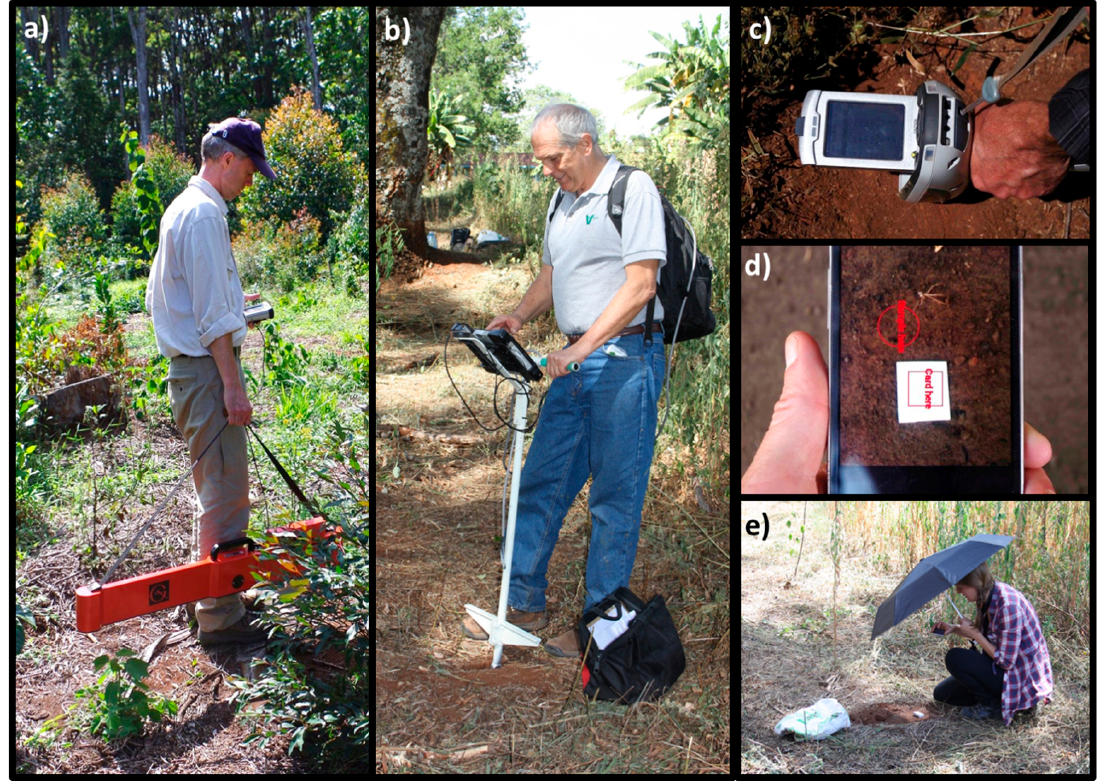
Figure 2. The proximal sensors tested: ( a ) an electromagnetic induction sensor; ( b ) an optical sensor; ( c ) a portable X-ray fluorescence sensor (PXRF); ( d ) a smartphone soil color application; and ( e ) the umbrella used for shading.